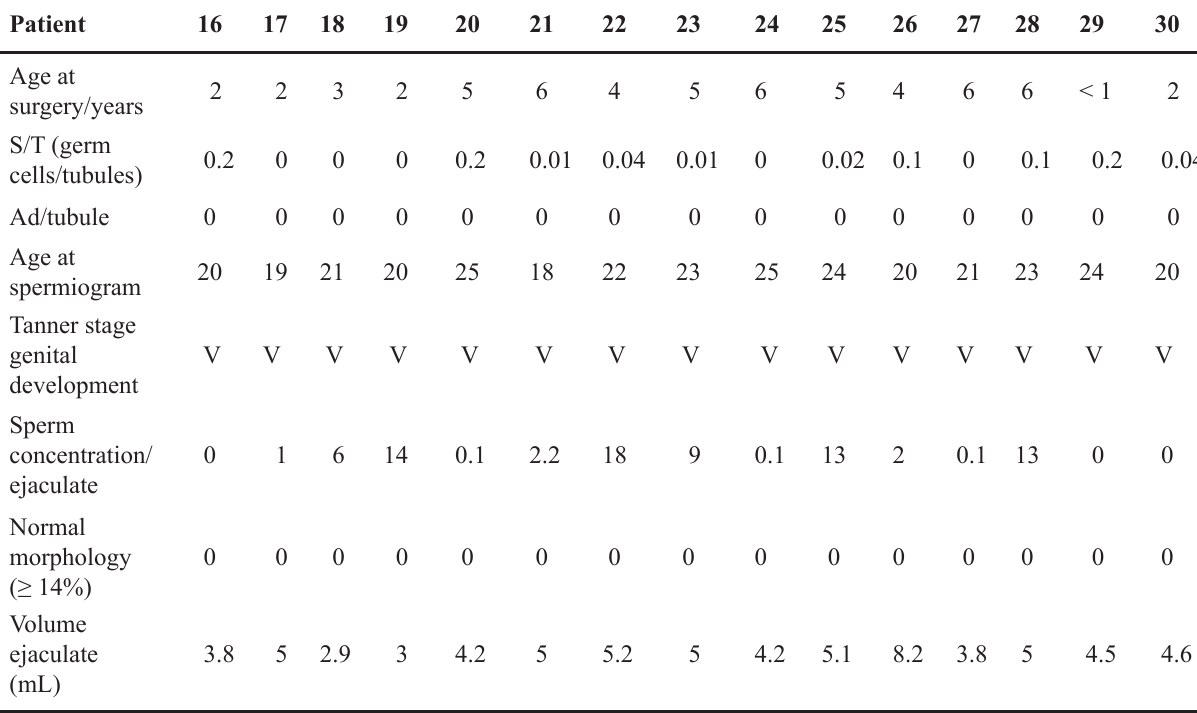
Table 3 – Characteristics of the 15 patients with cryptorchidism initially treated with surgery at follow up after puberty.